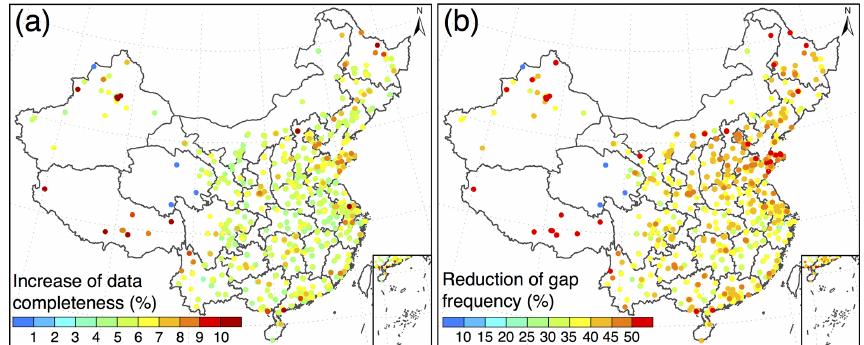
Figure 10. Benefits of the DCCEOF method to our retrieved in situ hourly PM 2 . 5 records at each individual monitoring station. (a) Improve- ment of data completeness ratio and (b) reduction of the percentage of days with